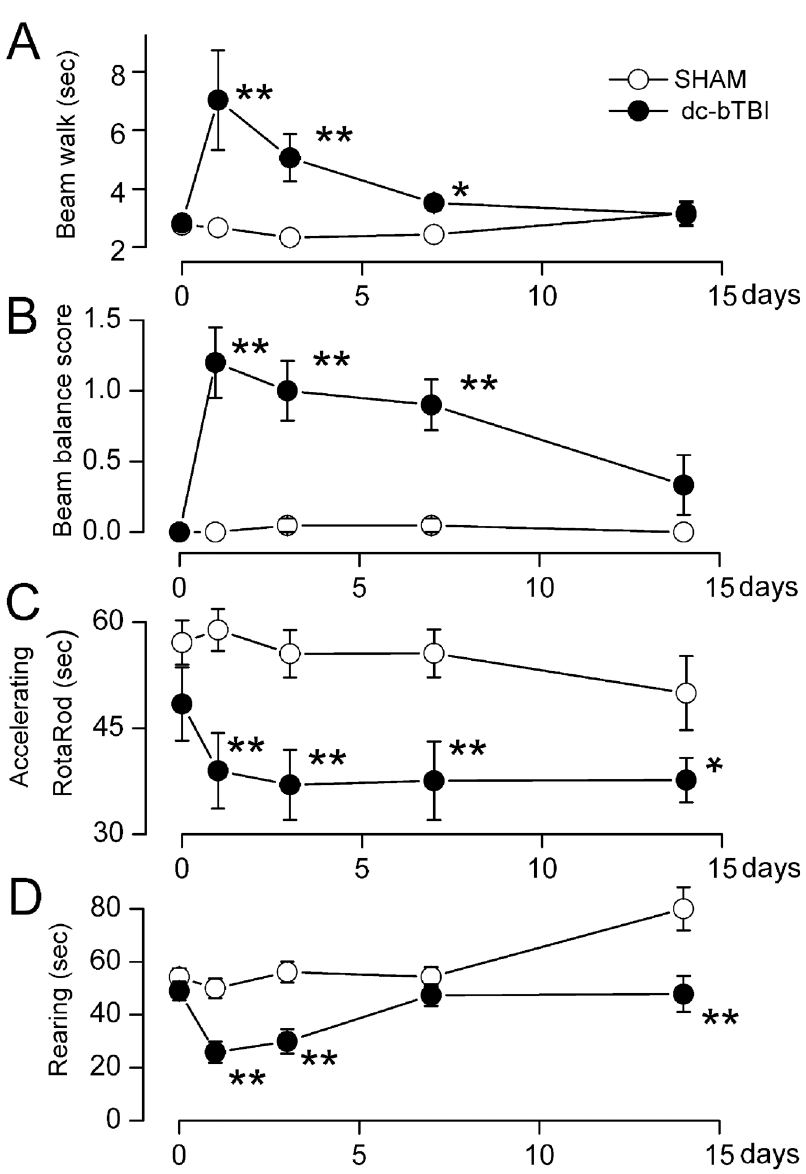
Fig 5. dc-bTBI causes abnormalities in vestibulomotor performance. A – D: performance on beam walk (A), beam balance (B), accelerating RotaRod (C) and spontaneous rearing (D) over the course of 1 – 14 days; n = 10 sham-injury, 10dc-bTBI; day 0 is baseline before dc-bTBI; * , p < 0.05; ** , p < 0.01for comparison between sham and dc-bTBI